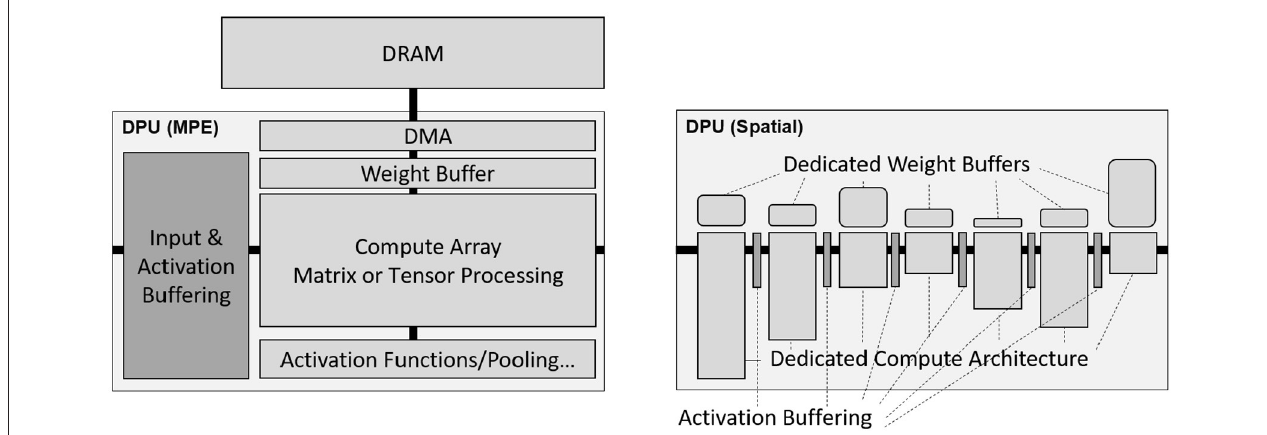
FIGURE 8 | DPU architectures: Matrix of Processing Engines (MPE) on the left, and spatial architecture on the right.